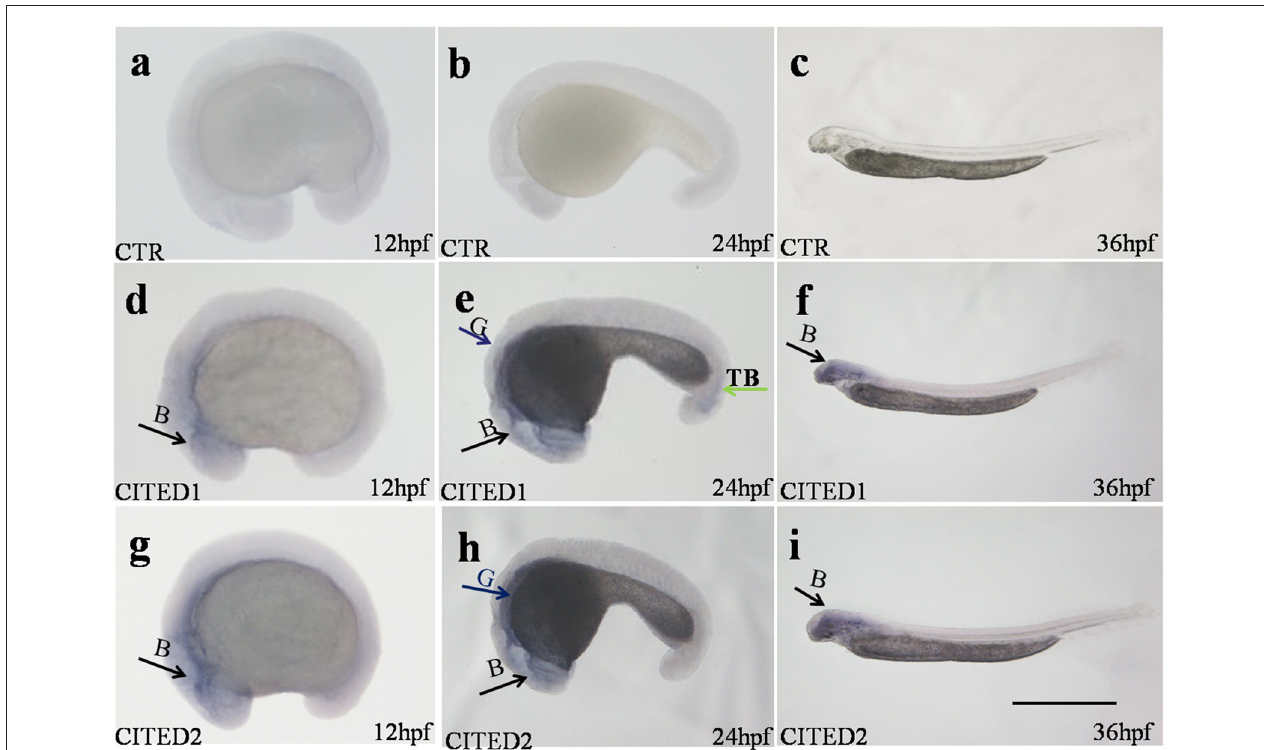
FIGURE 4 | Whole-mount embryo in situ hybridization analysis at different embryonic stages of CITED1 / -2 mRNA of blunt snout bream. CITED1 antisense probe (D–F) , CITED2 antisense probe (G–I) , and CITED1 or -2 sense probe (A–C) were used. All embryos are viewed laterally with the head to the left. B, brain; G, gut; TB, tail bud. Scale bar = 500 µ